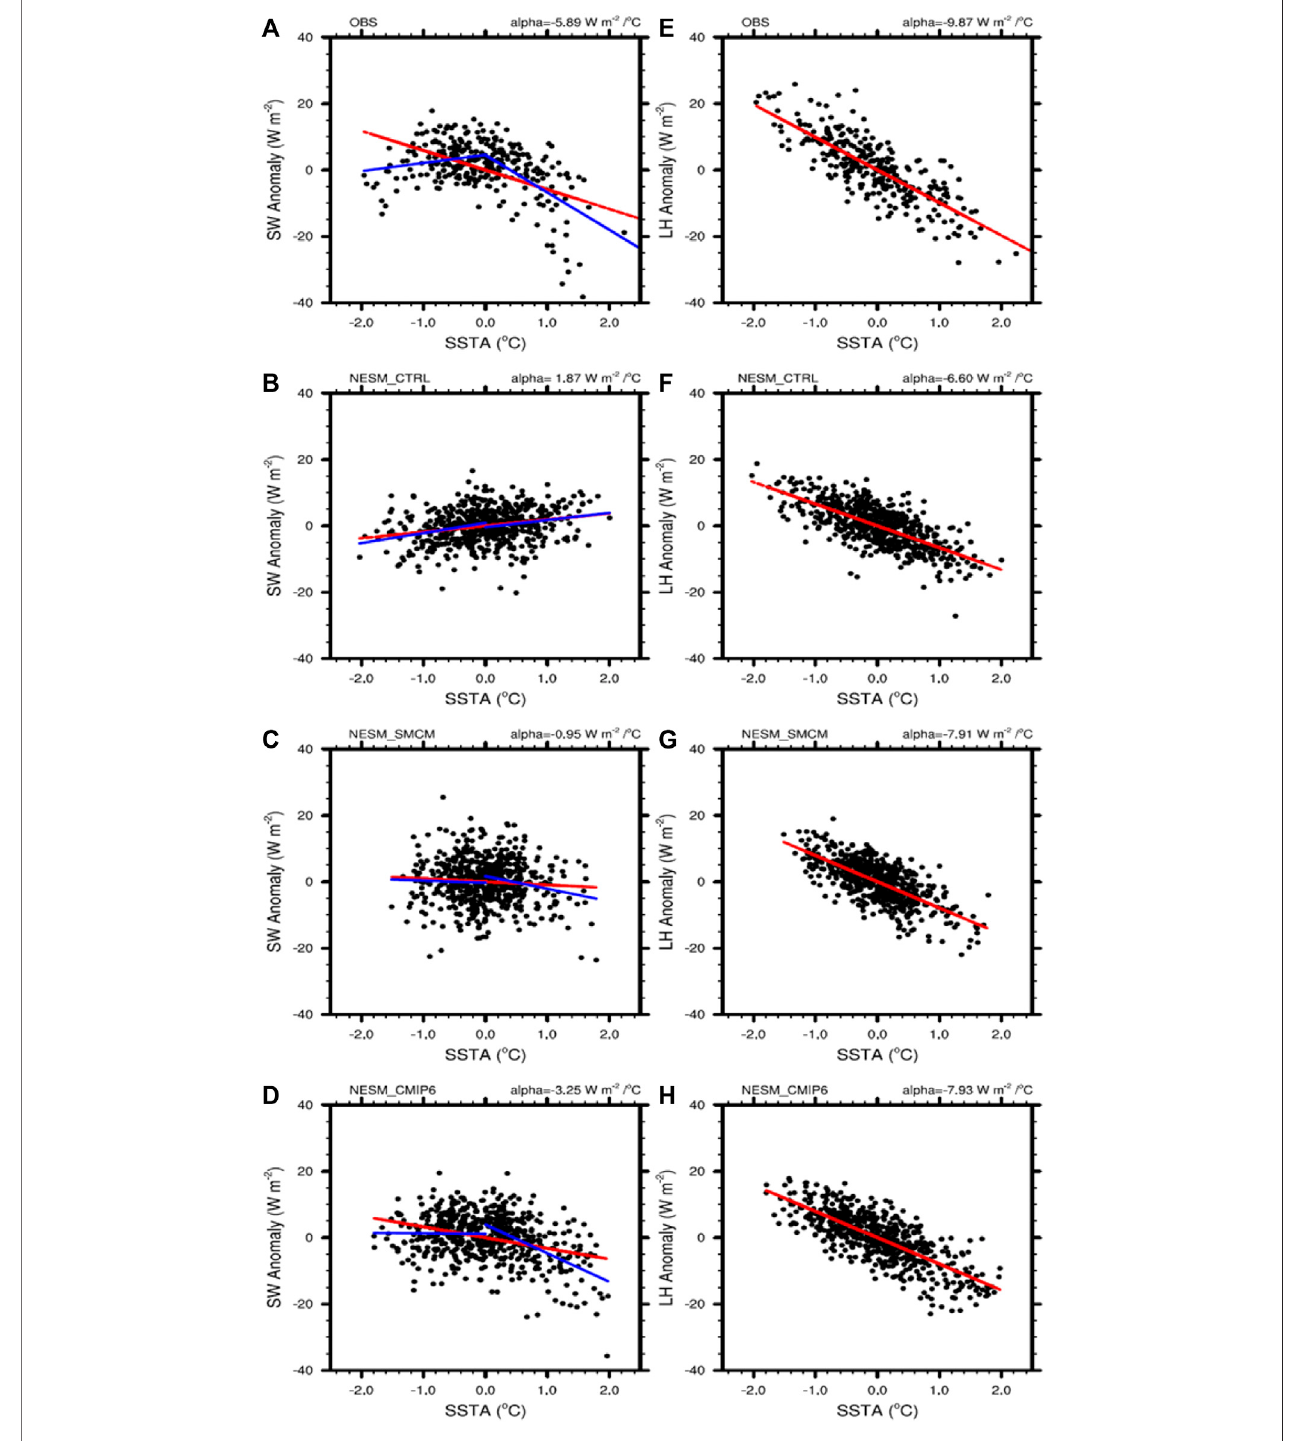
FIGURE 9 | Surface shortwave radiation (left panel) and latent heat fl ux (right panel) in the Niño 3 as a function of the Niño-3 SST anomalies: (A,E) observations, (B,F) NESM_CTRL, (C,G) NESM_SMCM, and (D,H) NESM_CMIP6.Theredlinesin (A – H) representthelinearregressionrelationship.Thebluelinesin (A – D) separately denote the linear regression with respect to negative and positive SSTA.